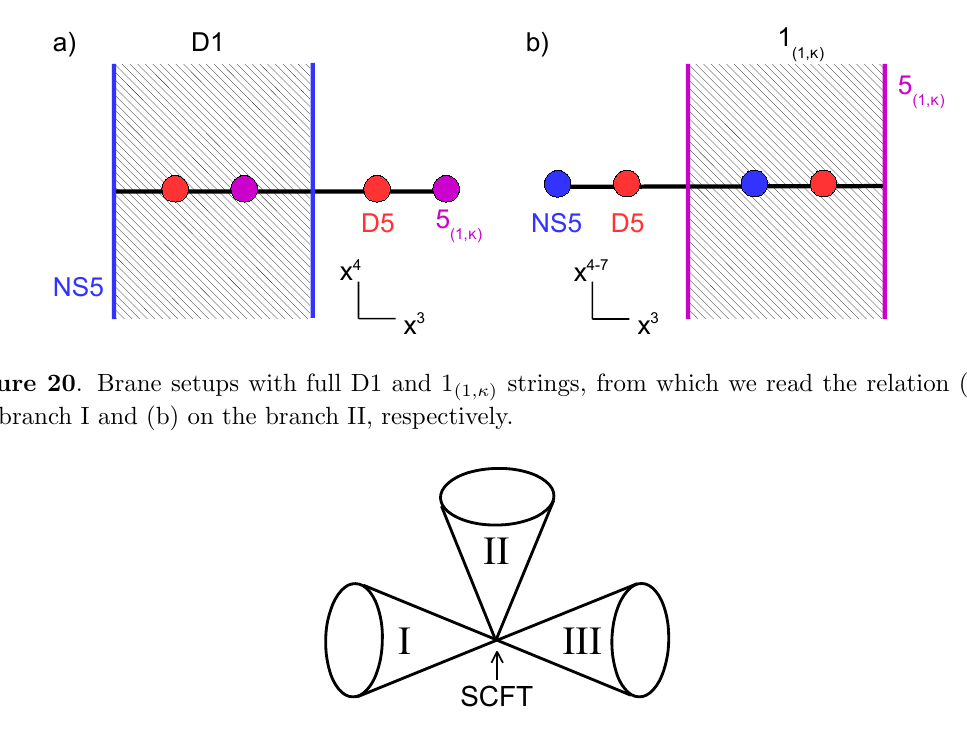
Figure 21 . Moduli space of the T [3] theory. There are three branches meeting at the origin (SCFT